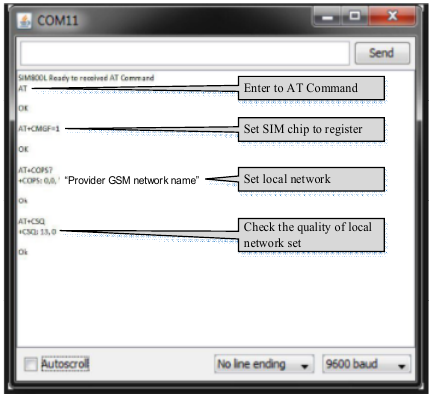
Figure 2. Serial monitor window with ATtention (AT) commands of the Arduino integrated development environment (IDE)